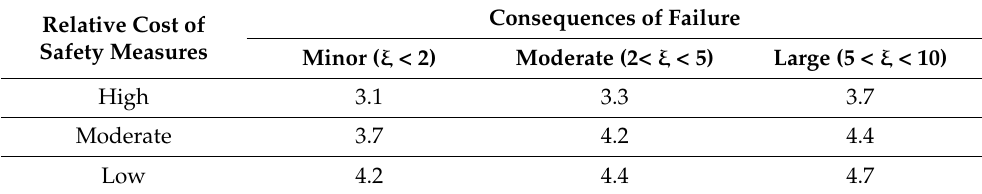
Table 4. Target β -values for structural systems (1 year) from JCSS Probabilistic Model Code.